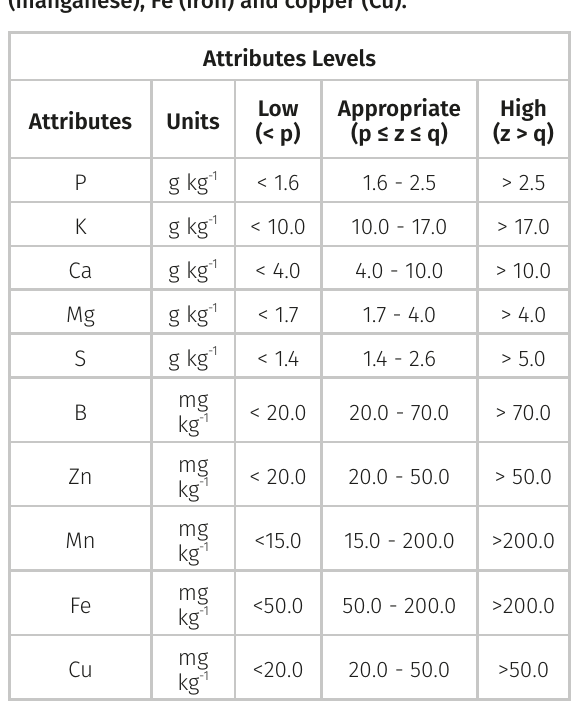
Table I. Criteria for classification of the degrees of membership (FI) of the leaf chemical attributes of the rubber tree: macronutrients: phosphorus (P), potassium (K), calcium (Ca), magnesium (Mg), sulfur (S) and micronutrients: B (boron), Zn (zinc), Mn (manganese), Fe (iron) and copper